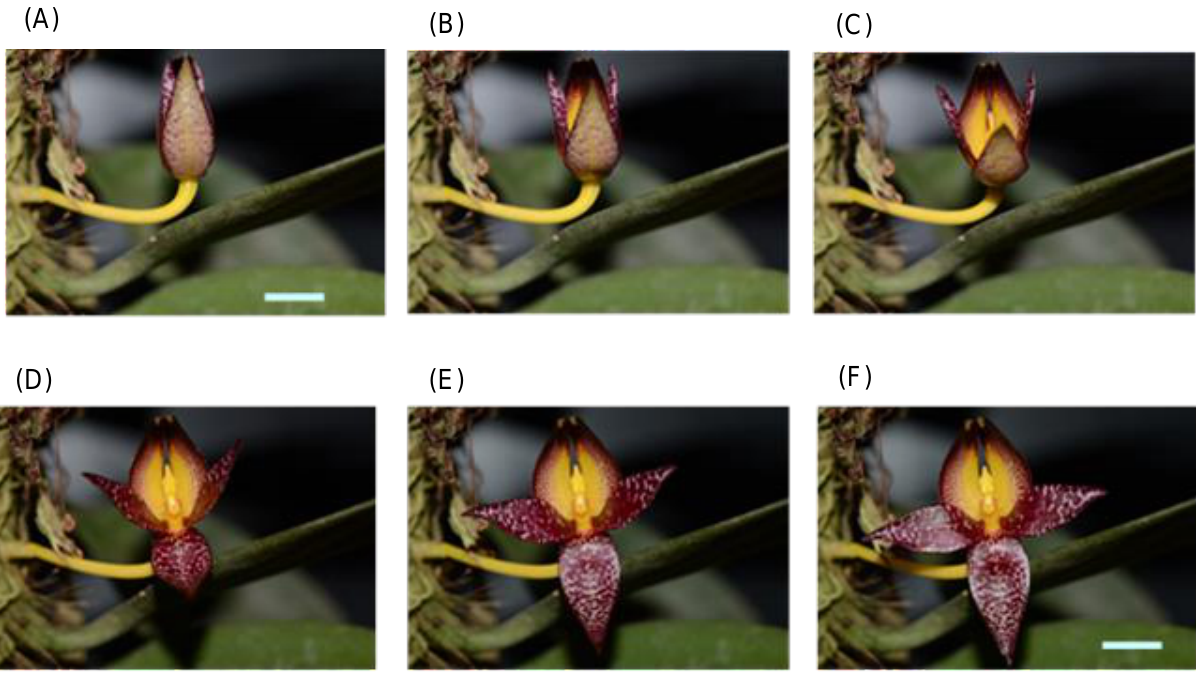
F IGURE 1. Anthesis of Bulbophyllum praetervisum. Bar: 1 cm (A) Bud begun to open (at 05:50 h). (B) 40 minutes later. (C) 1 hour later. (D)